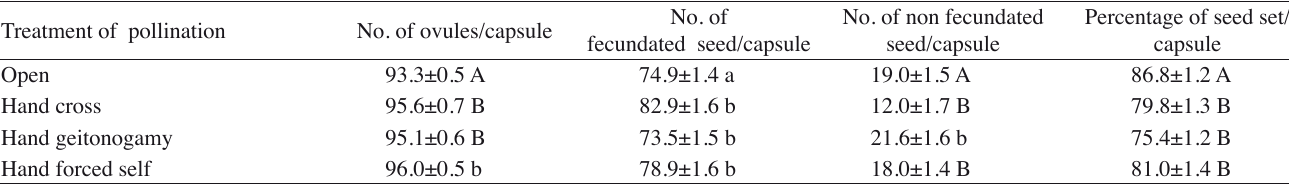
Table 1 - Seeds set after different pollination treatments in Nigella sativa , location A. Season one Treatment of